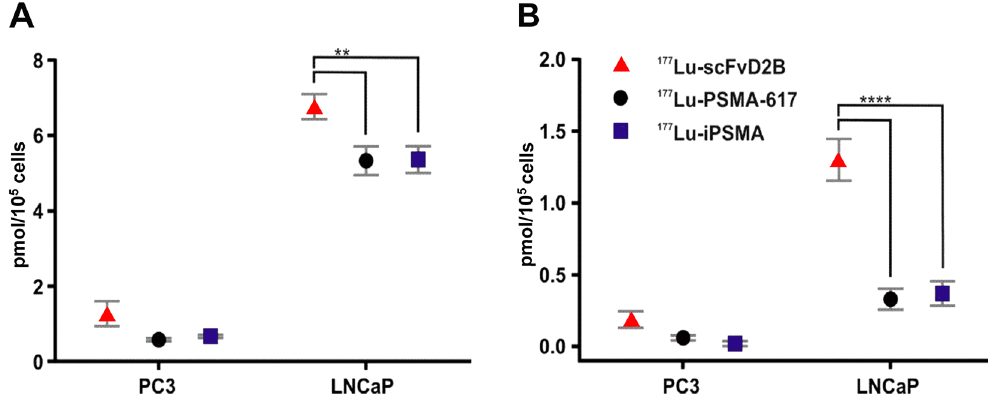
Figure 3. ( A ) Cell uptake and ( B ) internalization of 177 Lu-labeled scFvD2B, 177 Lu-PSMA-617 and 177 Lu- iPSMA by PSMA-negative PC-3 and PSMA-positive LNCaP cells, after 2 h of incubation with 2 MBq of 177 Lu- radiotracers (16 MBq/nmol) at 37 °C. Bars represent the average value ± SD of one experiment performed in triplicate, ** p < 0.005 and **** p < 0.0001, two-way ANOVA.